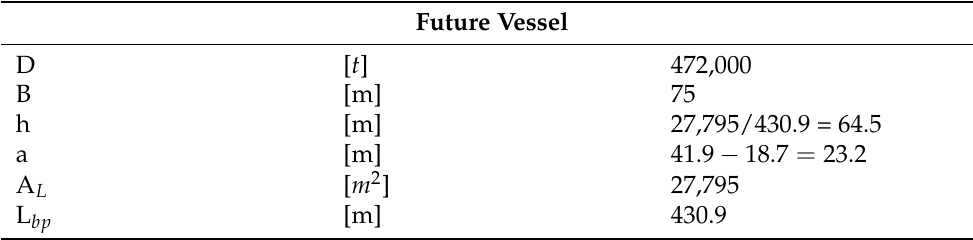
Table 2. Future vessel characteristics.